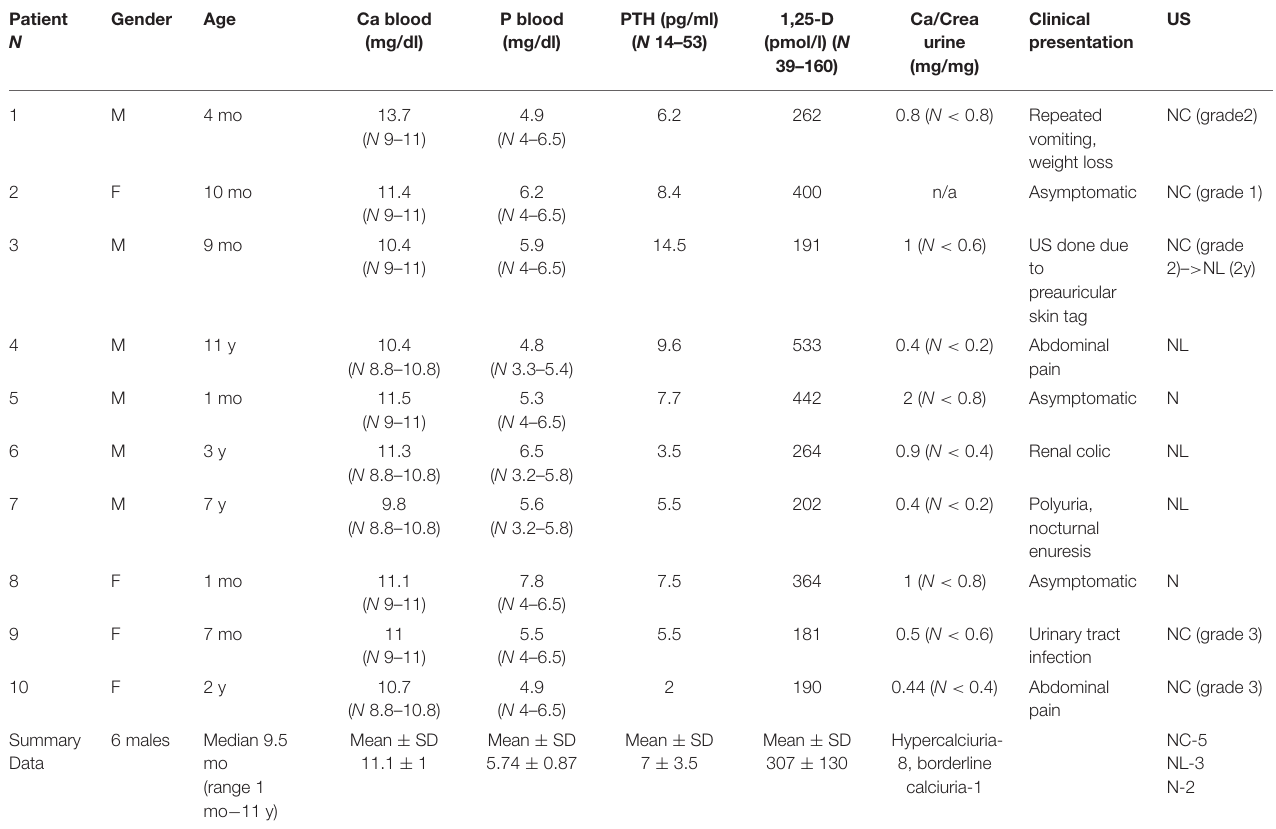
TABLE 1 | Clinical and laboratory data at